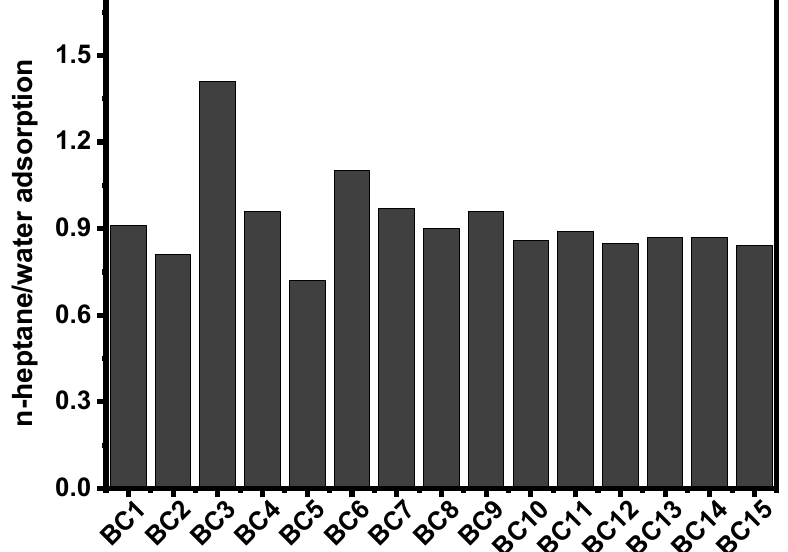
Figure 9. Hydrophobicity/hydrophilicity index of the biochars based on ratio of n-heptane/water adsorption .